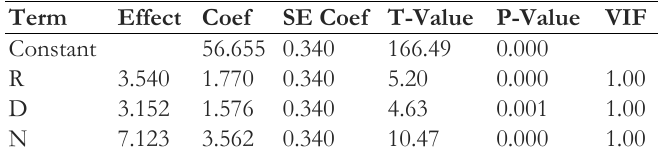
Table 6. Coded coefficient for factorial regression: means versus D and